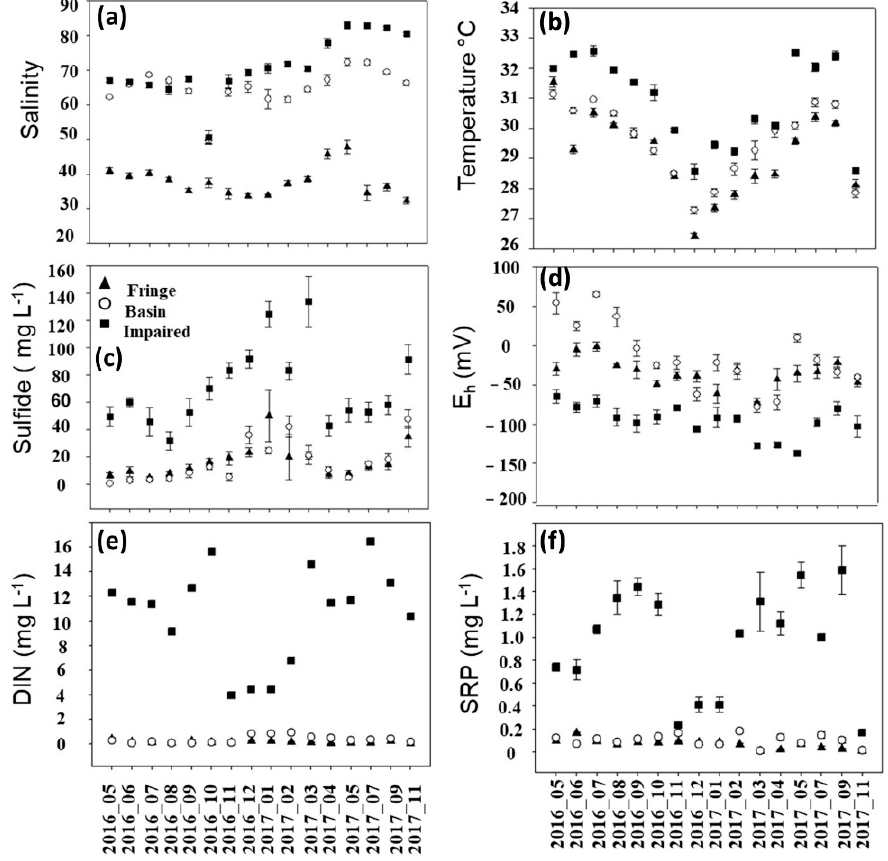
Figure 4. Temporal variation (mean ± SD) of ( a ) salinity, ( b ) temperature, ( c ) sulfide, ( d ) Eh, ( e ) dis- solved inorganic nitrogen (DIN), and ( f ) soluble reactive phosphorus (SRP) in the fringe (triangles), basin (circles), and impaired (squares) mangrove sites.